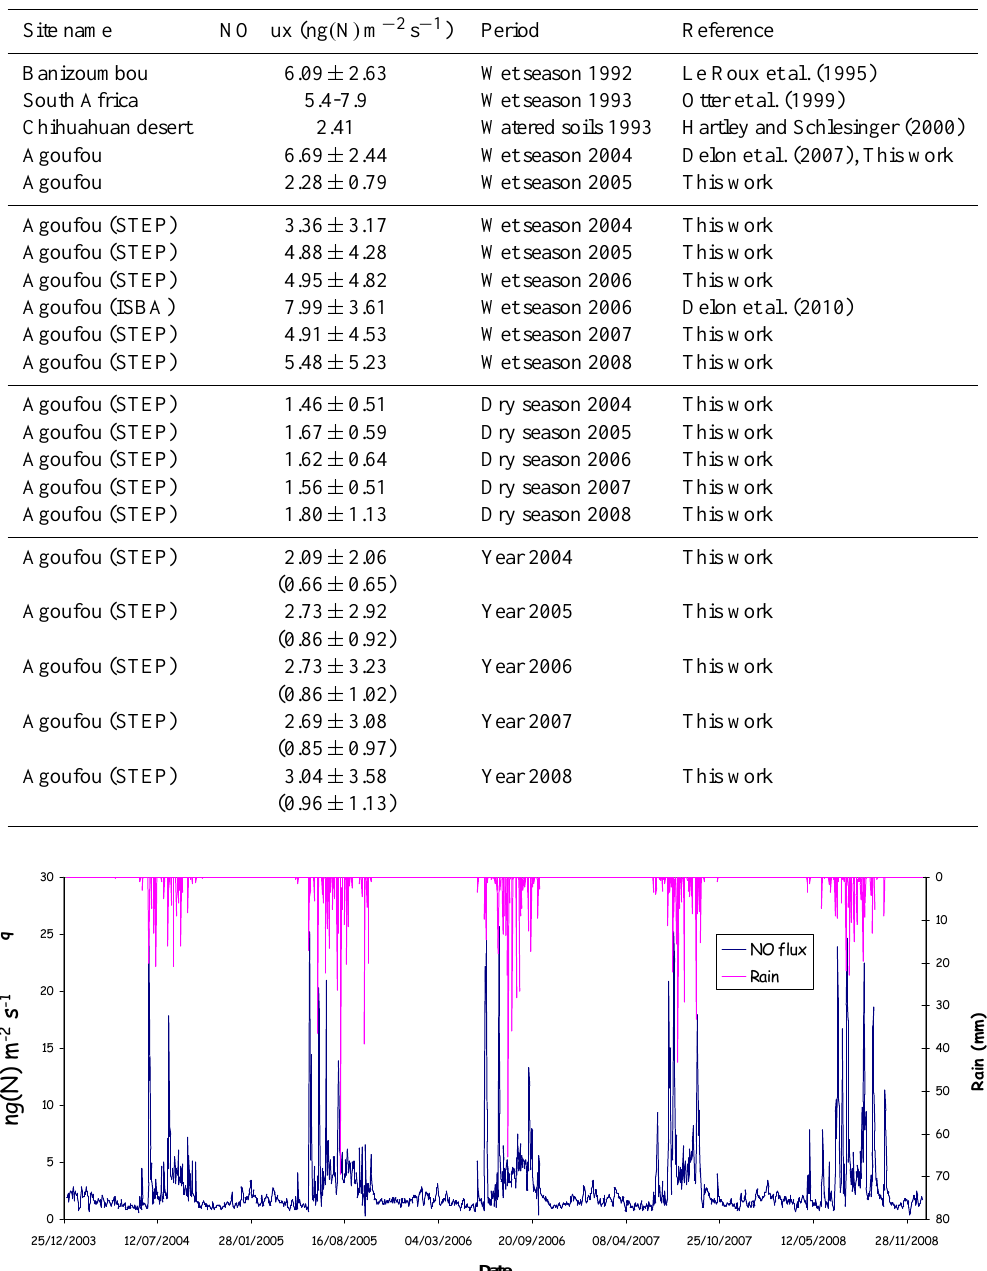
Table 3. Comparison of experimental and simulated NO fluxes (daily scale) during various wet and dry seasons in dry savanna sites. The model used is indicated in parentheses. No model specified means experimental data. For yearly means, values are also indicated in kg ( N ) ha − 1 yr − 1 in parentheses.